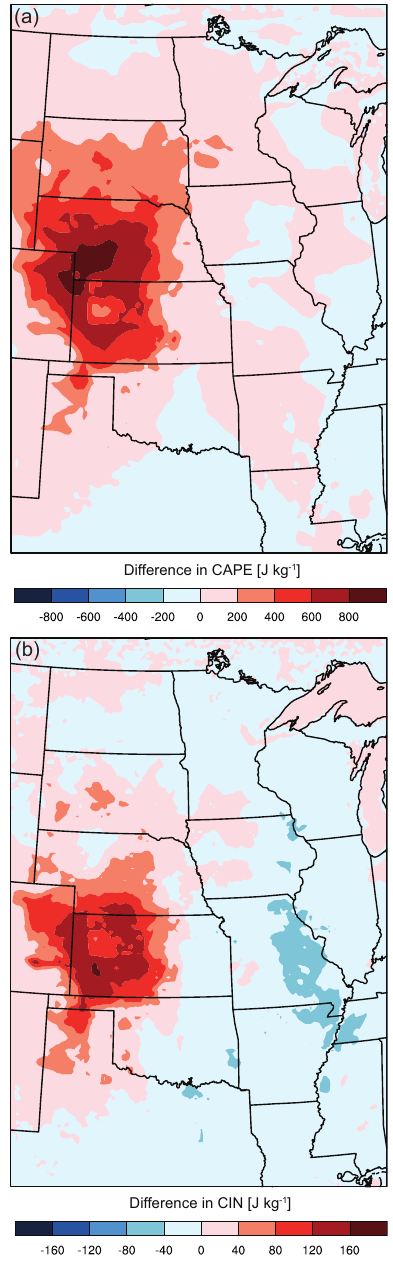
Figure 7. Differences in monthly-mean ( a ) CAPE (J · kg − 1 ) and ( b ) CIN (J · kg − 1 ) between IRR and CTL simulations for the month of